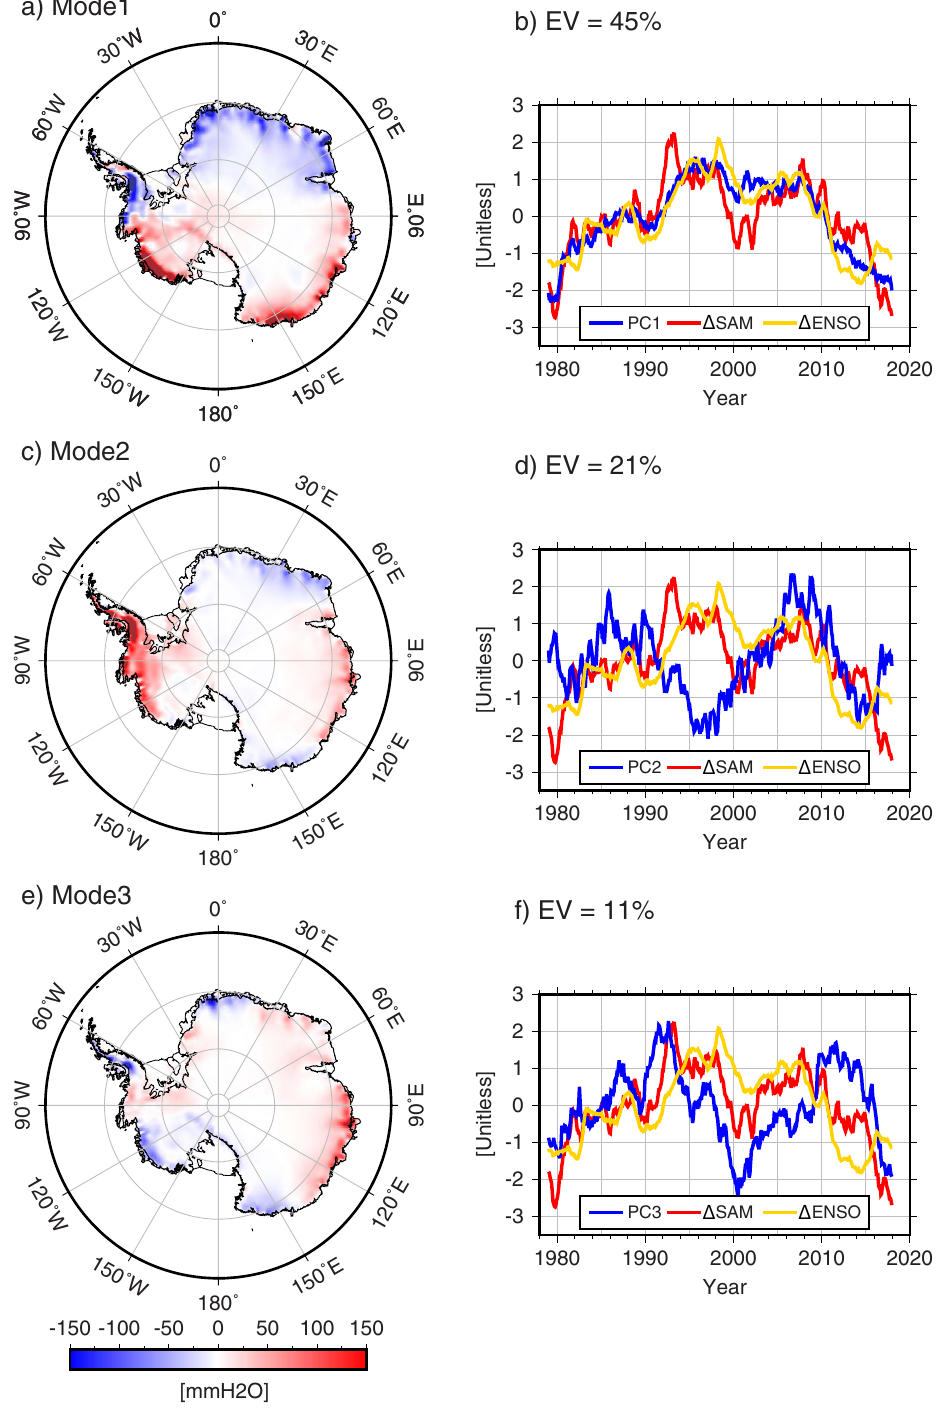
Figure 2. Leading three modes of EOF analysis from AIS (cid:31) SMB (accumulated precipitation). Each of red and yellow lines in right panels show (cid:31) SAM (time-integrated) and (cid:31) ENSO (time-integrated), respectively. For clarity, both (cid:31) SAM and (cid:31) ENSO are displayed reversed in sign. Figures are created with Generic Mapping Tools (GMT-5.4.5, https ://gmt.soest .hawai